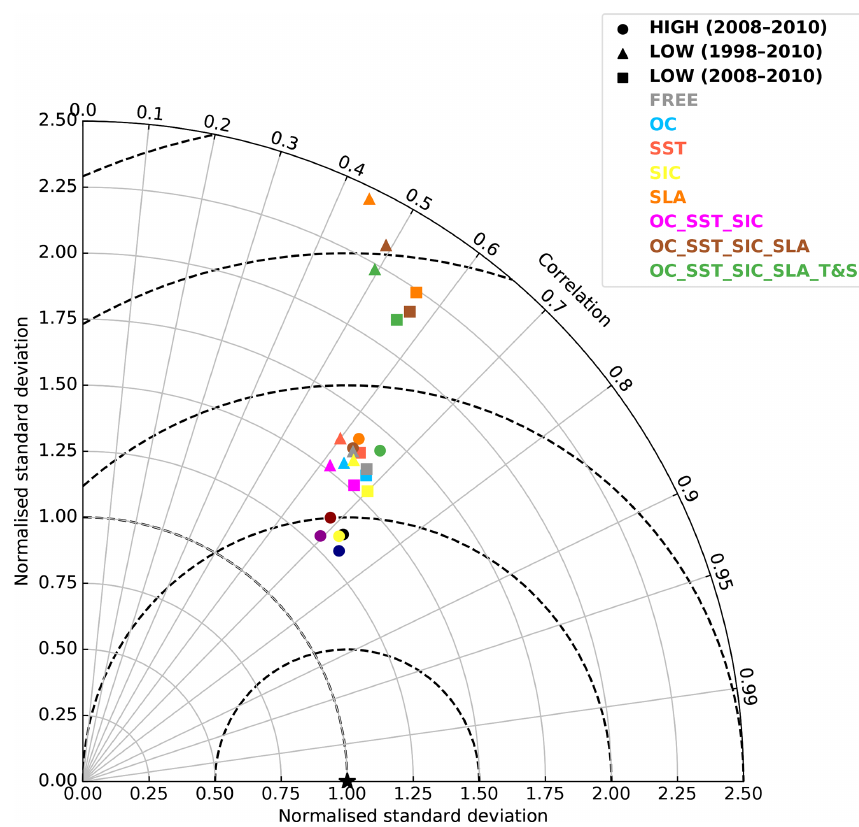
Figure 7. Taylor plot showing global f CO 2 statistics against SOCAT v2 for each